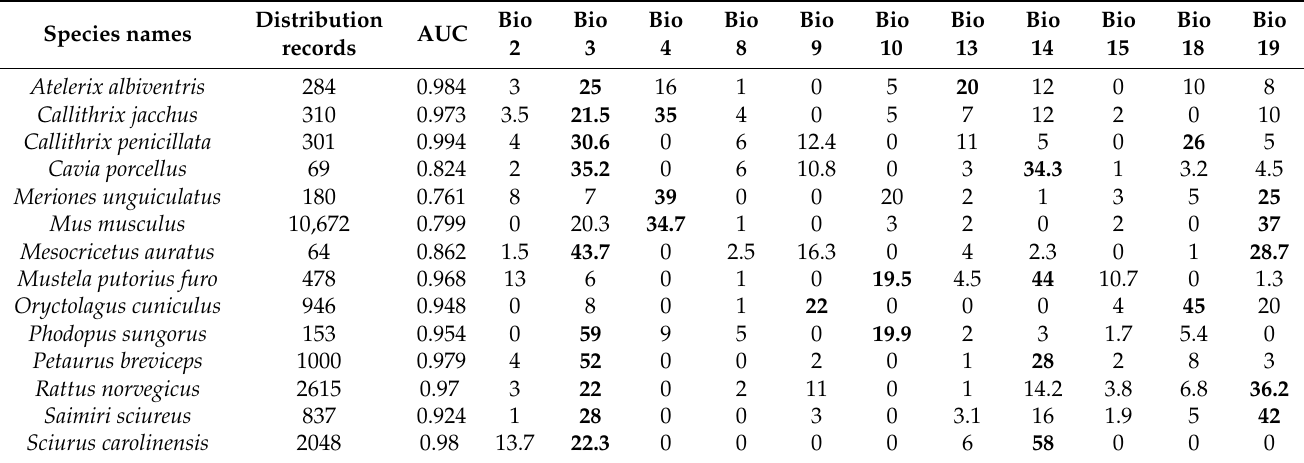
Table 3. Predictor variables, the percentage contribution, and AUC training values for the 14 non-native mammalian species sold as pets in South Africa. Bioclimatic variables contributing the most are shown in bold for each species, and the full description for each variable is provided in the